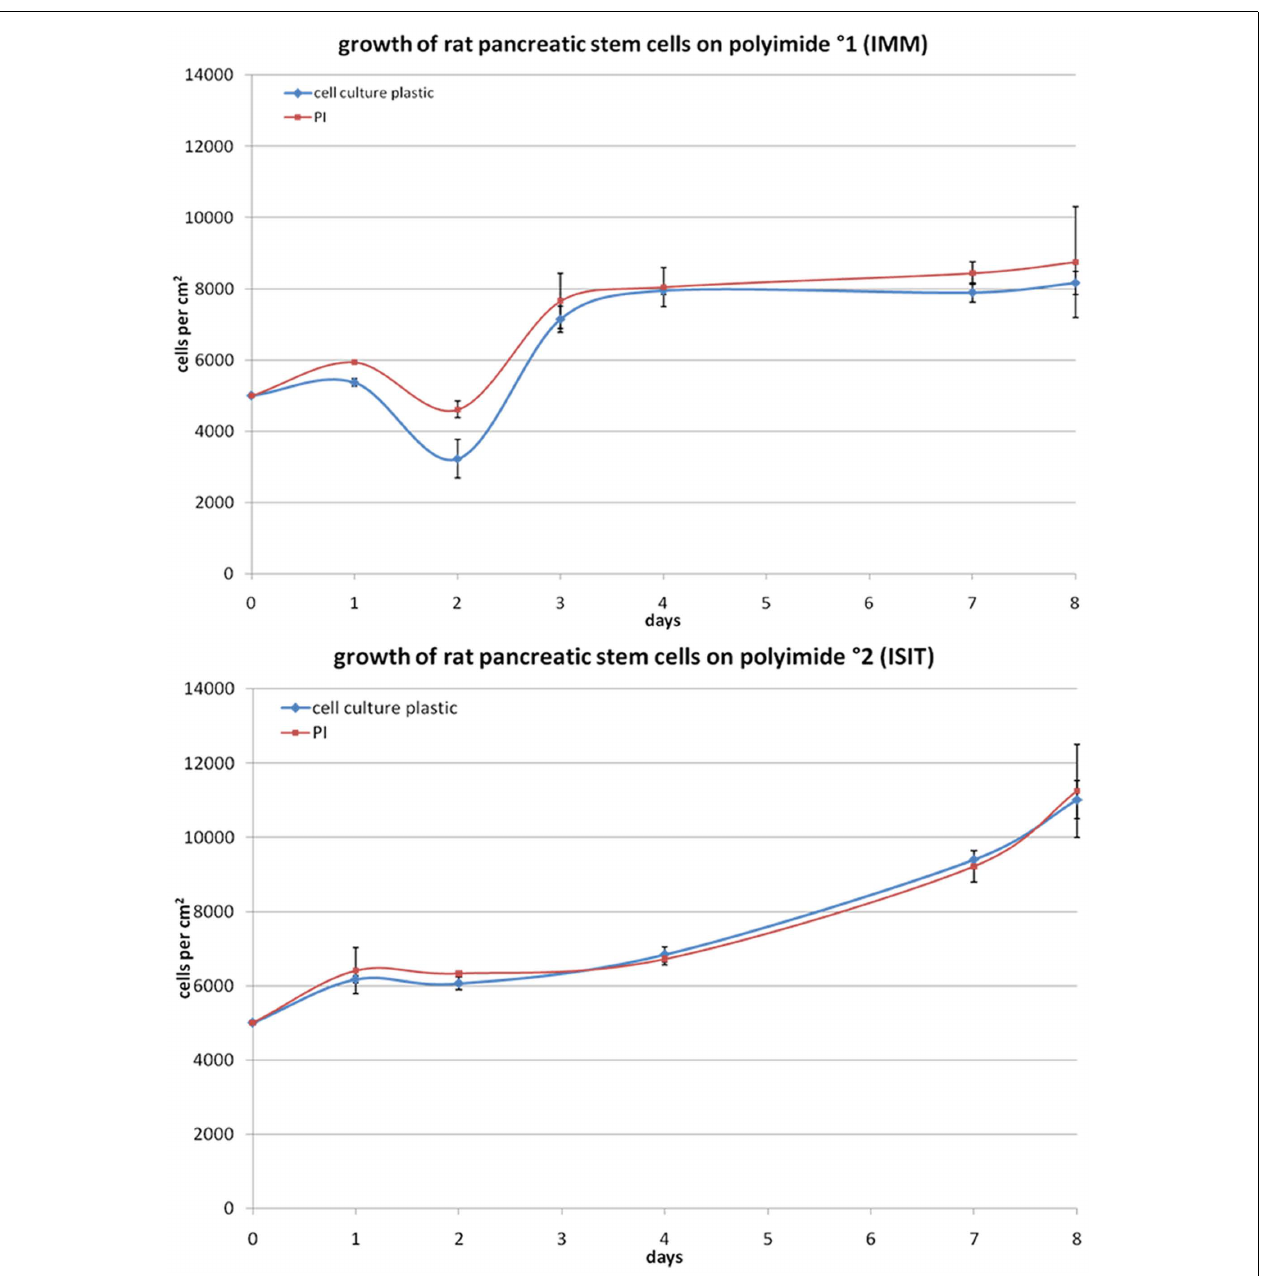
FIGURE 2 | Growth behavior of rat pancreatic stem cells on polyimide˚1 (left) and polyimide˚2 (right) in passage 9 measured after trypsinization of the samples with the Nucleocounter